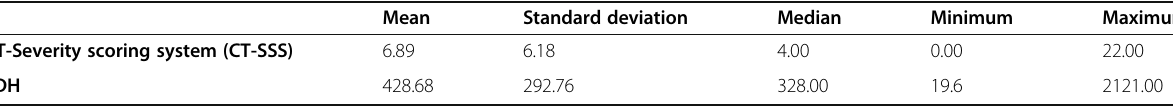
Table 1 CT-SSS and LDH spectrum in the